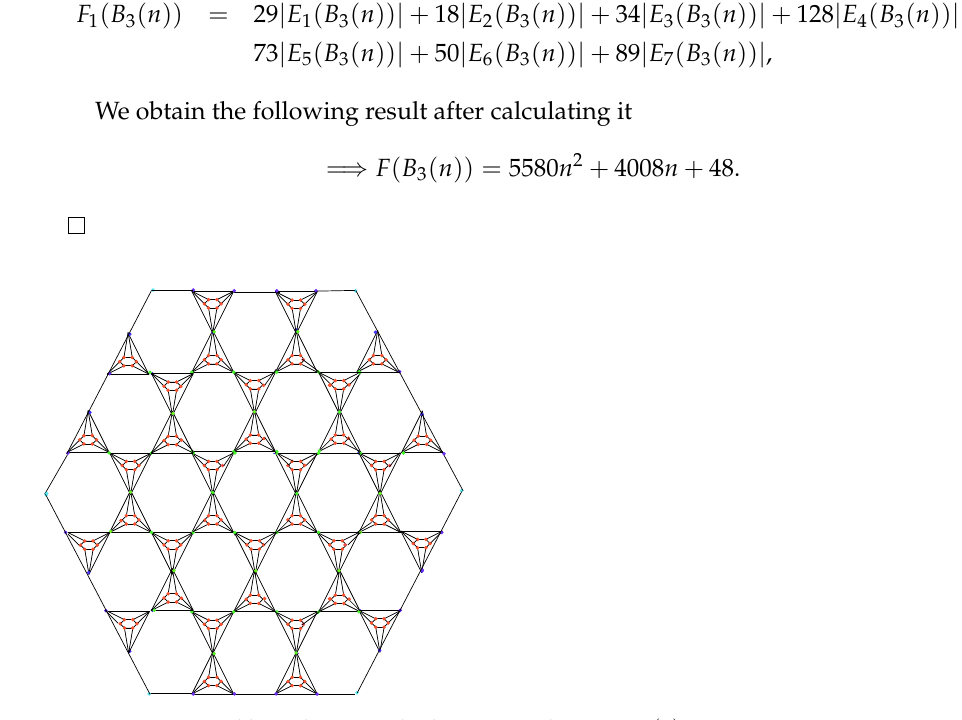
Figure 3. Benzenoid hex planar octahedron network BHPOH ( 2 ) . Table 5. Degree-based edge partition for BHPOH ( n )